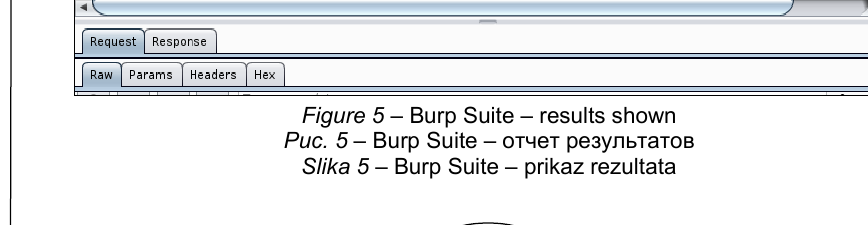
Figure 5 – Burp Suite – results shown Рис . 5 – Burp Suite – отчет